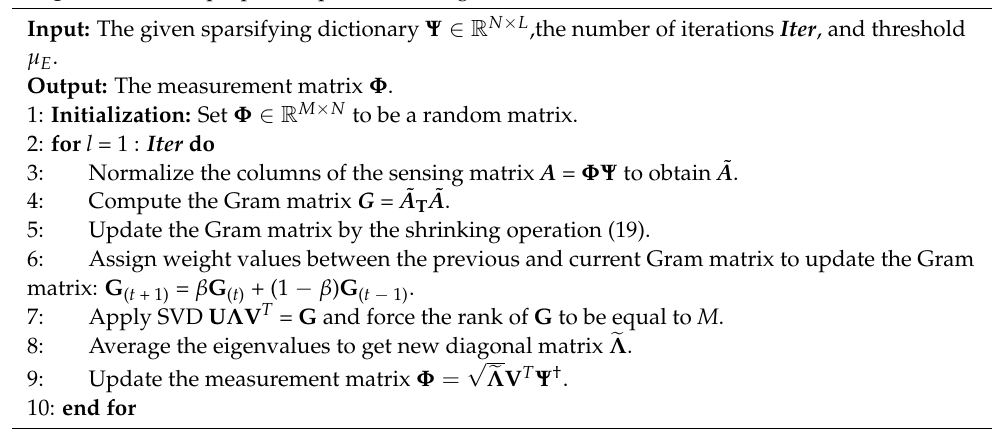
Algorithm 1: The proposed optimization